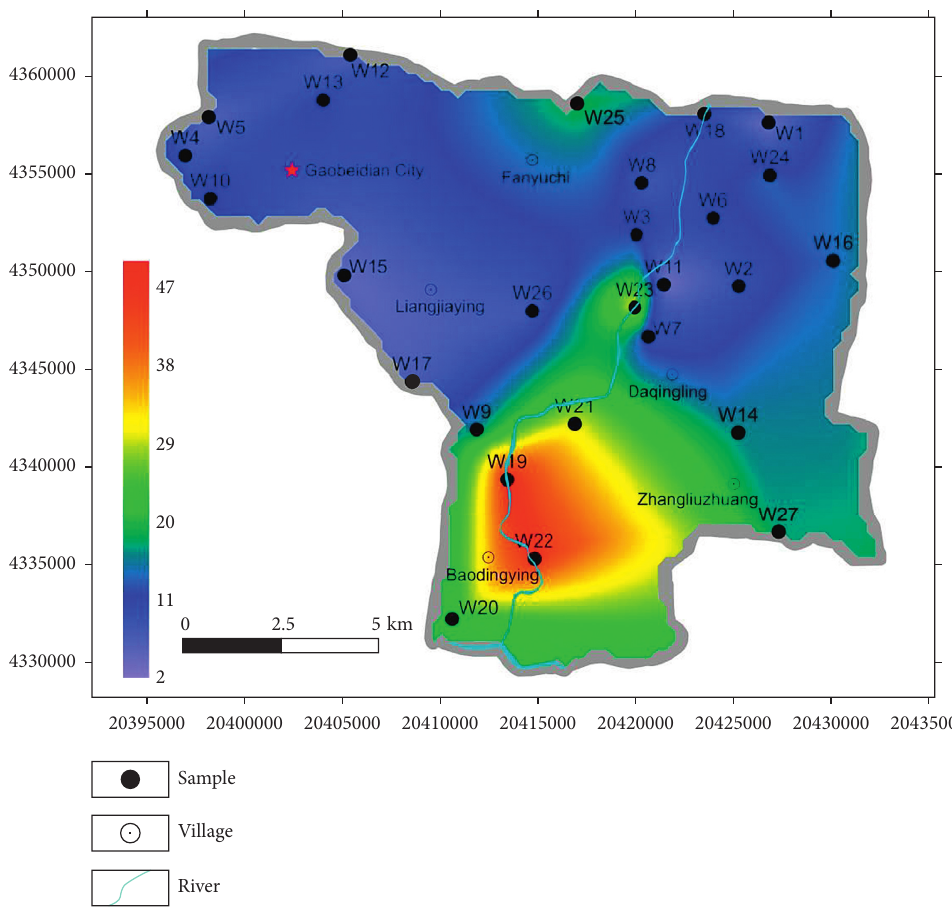
Figure 5: Spatial distribution of groundwater quality of the shallow aquifer. Table 5: Human noncarcinogenic and carcinogenic health risks in the groundwater.